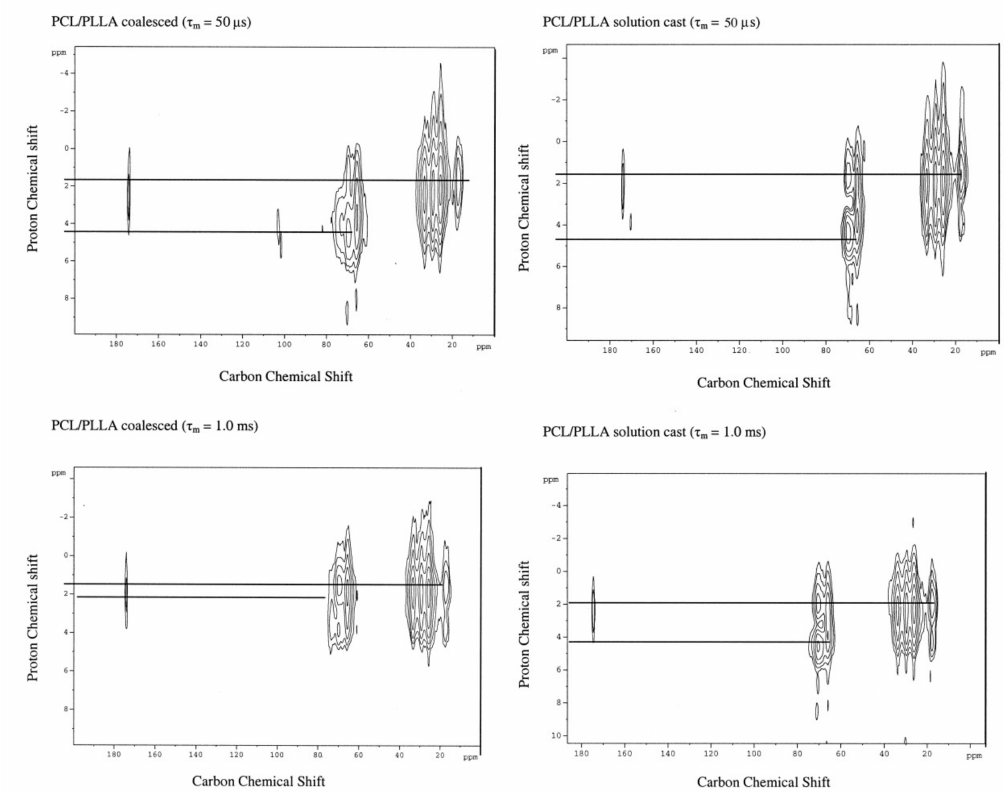
Figure 10. 2D 1 H- 13 C heteronuclear correlation (HETCOR) spectra of solution-cast and. Coalesced PCL / PLLA blends. Reproduced with permission from [28]. Copyright 2004 Wiley Periodicals,